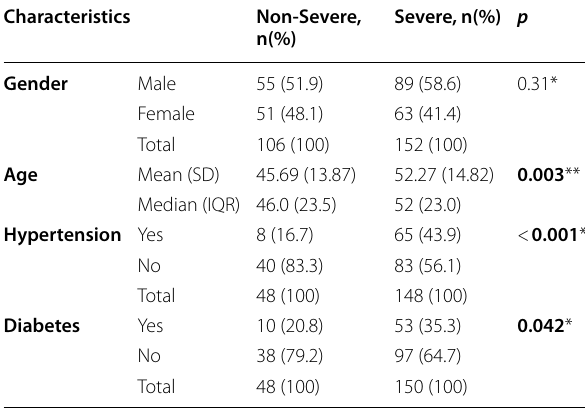
Analyzed by *χ 2 and ** Mann-Whitney tests